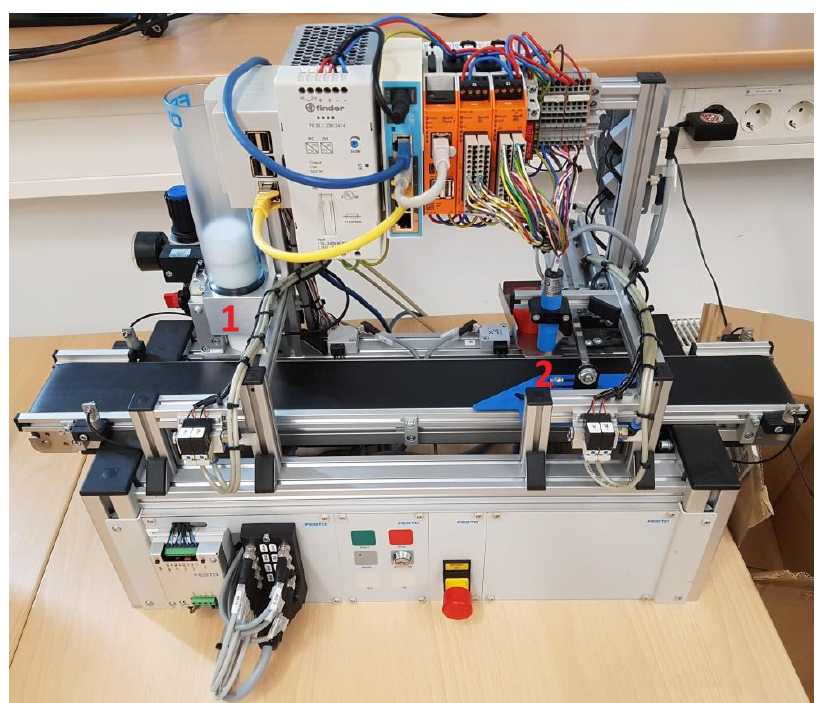
Figure 3 . The smart factory